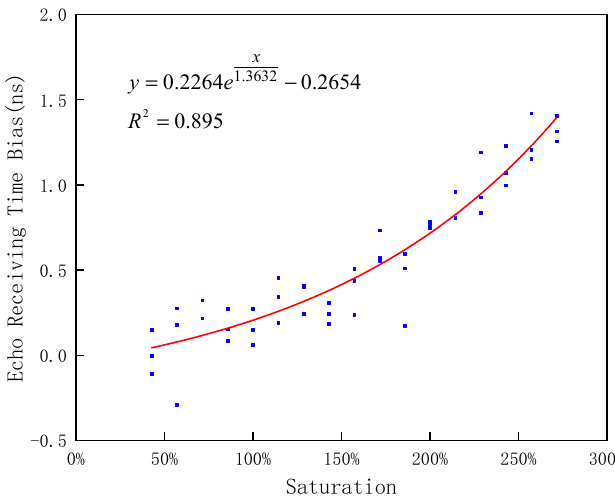
Figure 12. The variation of the laser signal receiving time deviation with saturation.